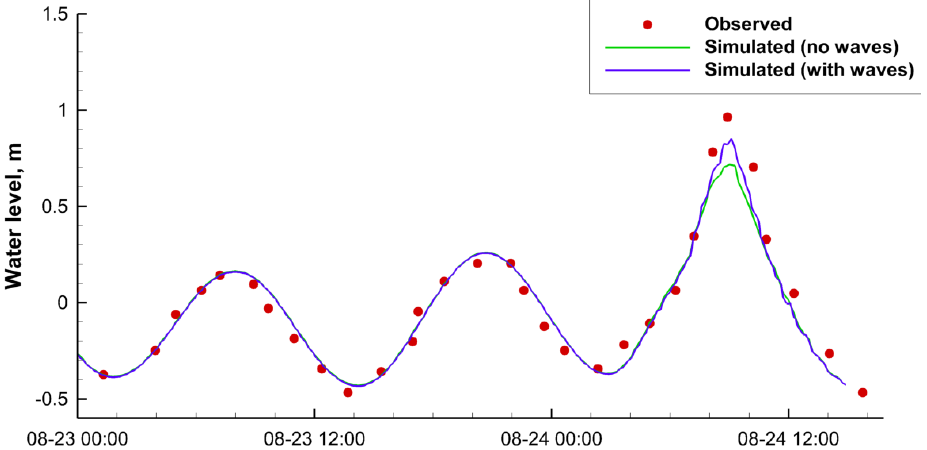
Figure 12. Comparison of observed and simulated (hindcast) water levels at the Haulover Pier station during Hurricane Andrew (1992). “No waves” curve shows results based on CH3D model that does not include wave effects and “with waves” shows results based on the coupled CH3D-SWAN model.